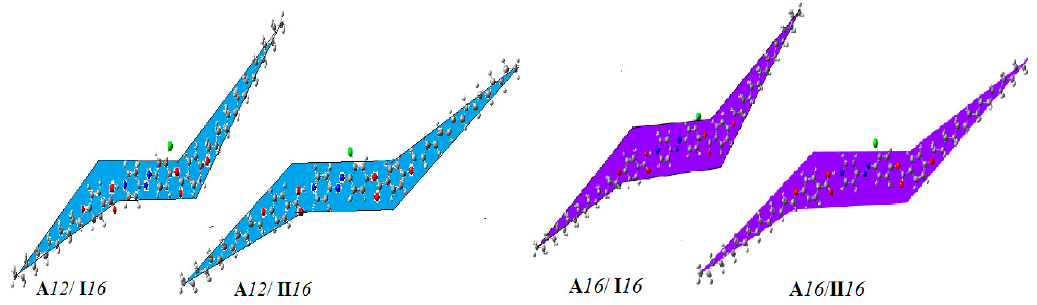
Figure 6. Optimized chair geometrical structures of A 12 / I 16 , A 12 / II 16 , A 16 / I 16 , and A 16 / II 16 . Table 3. Parameters (Hartree/particle) and dipole moment (Debye) of A 12 / I 16, A 16 / I 16 , and A n / II m . Parameter